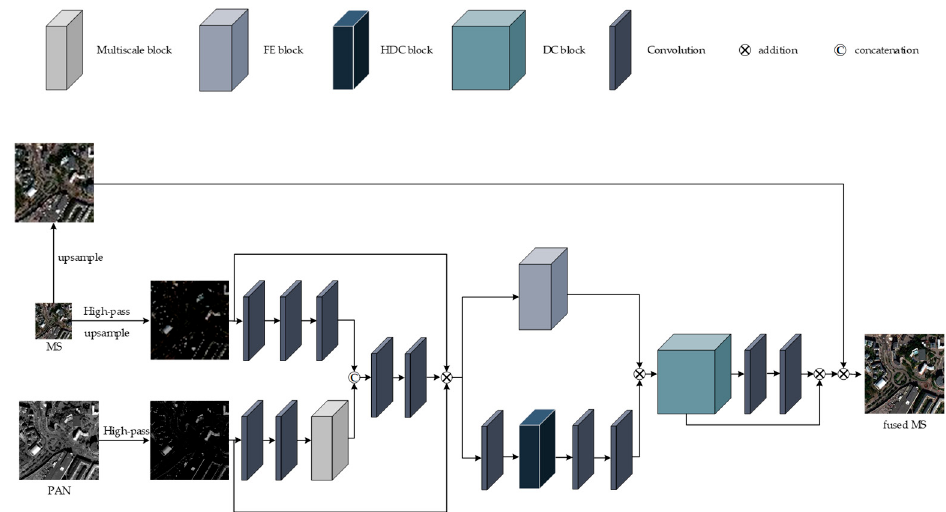
Figure 2. The detailed architecture of the proposed multiscale perception dense coding convolutional neural network (MDECNN).